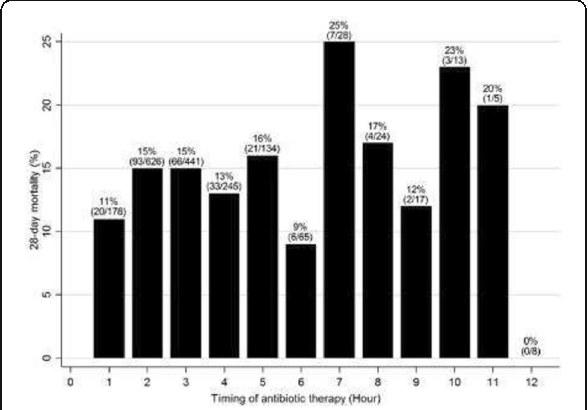
Fig. 1 (abstract 0256). Anti-time and mortality